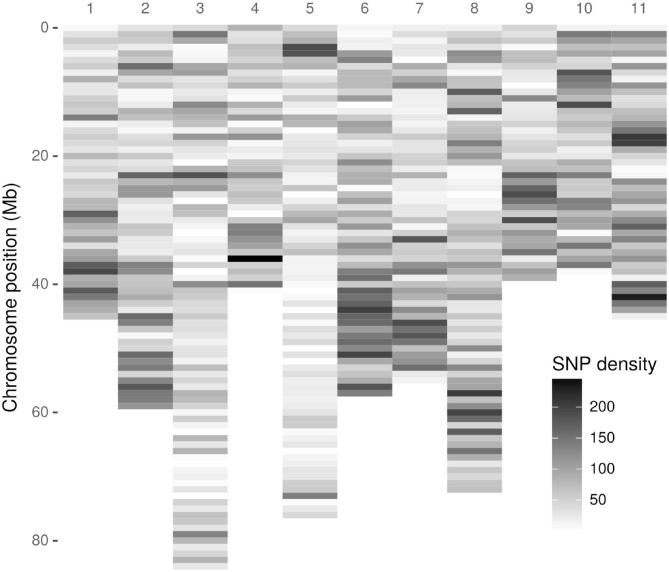
Density distribution of Discovery-identified Acca sellowiana single nucleotide polymorphisms (SNPs) across the Eucalyptus grandis chromosomes. The SNP density was estimated in a 1 Mb window. The y-axis indicates the physical position in Mb. Of the 43,377 Discovery-identified SNPs, 41,815 were distributed across the E. grandis chromosomes and showed in the graphic. The remaining 1525, identified in sequence scaffolds, are not displayed.